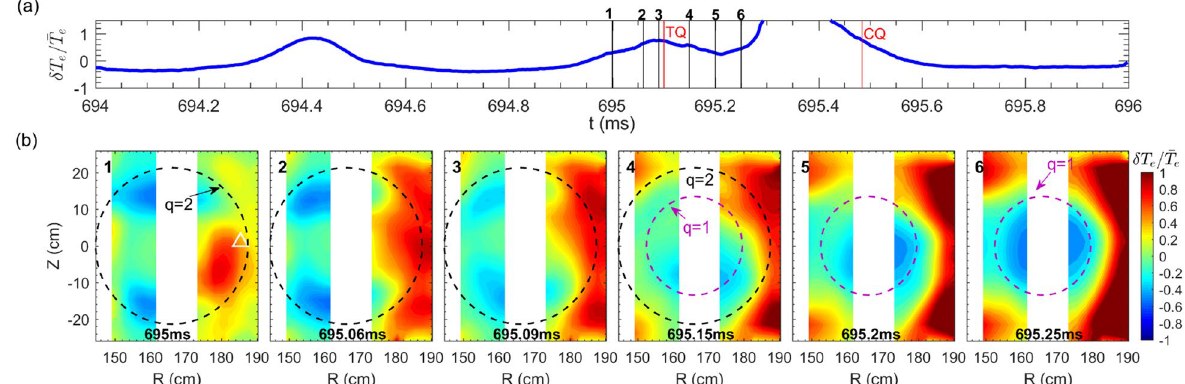
Figure 8. Time evolutions of the MHD instability behaviors towards the plasma disruption: ( a ) relative temperature perturbation ( δ T e / ¯ T e ) measured at R = 185.3 cm and Z = 1.13 cm (marked by the white triangle in the first image of Fig. 8b). The onsets of the TQ and CQ are denoted by vertical red lines. ( b ) ECE images taken at six time points marked by vertical lines in Fig. 8a. The q = 2 and q = 1 surfaces are illustrated by black and purple dashed circles, respectively